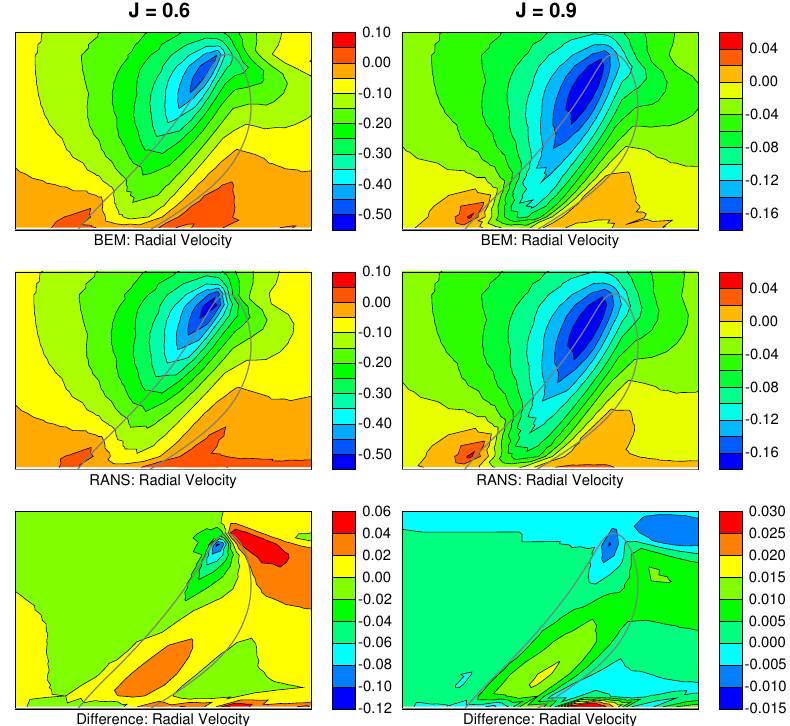
Figure 5. RANS and BEM radial velocity fields for DTMB P4384 at J = 0.6 and 0.9. The velocities are normalized using the inflow speed V .